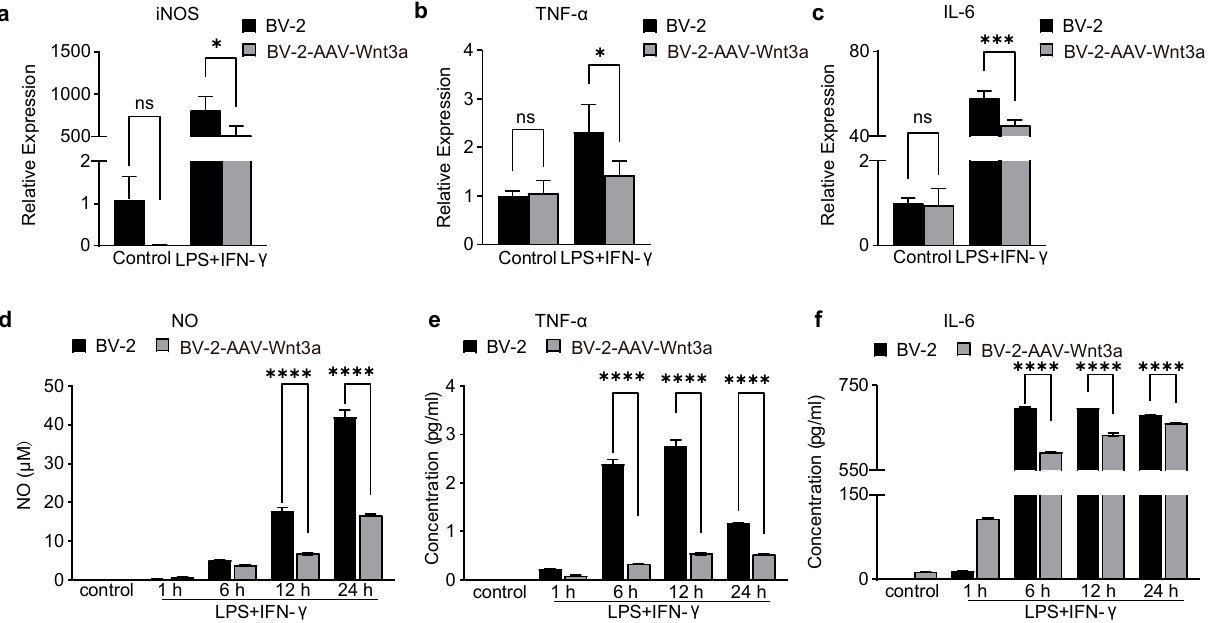
Figure 4. Overexpression of Wnt3a decreased NO, TNF- α , and IL-6 production in LPS and IFN- γ -stimulated BV-2 microglia cells. Overexpression of Wnt3a decreased mRNA level of ( a ) iNOS, two-way ANOVA, * p = 0.0139, n = 3. ( b ) TNF- α , two-way ANOVA, * p = 0.0319, n = 3; ( c ) IL-6, two-way ANOVA, *** p = 0.0002, n = 3. ( d ) The time course of NO production in LPS/IFN- γ -induced cells. Two-way ANOVA, **** p < 0.0001. n = 3. Wnt3a reduced the release of TNF- α . Two-way ANOVA,